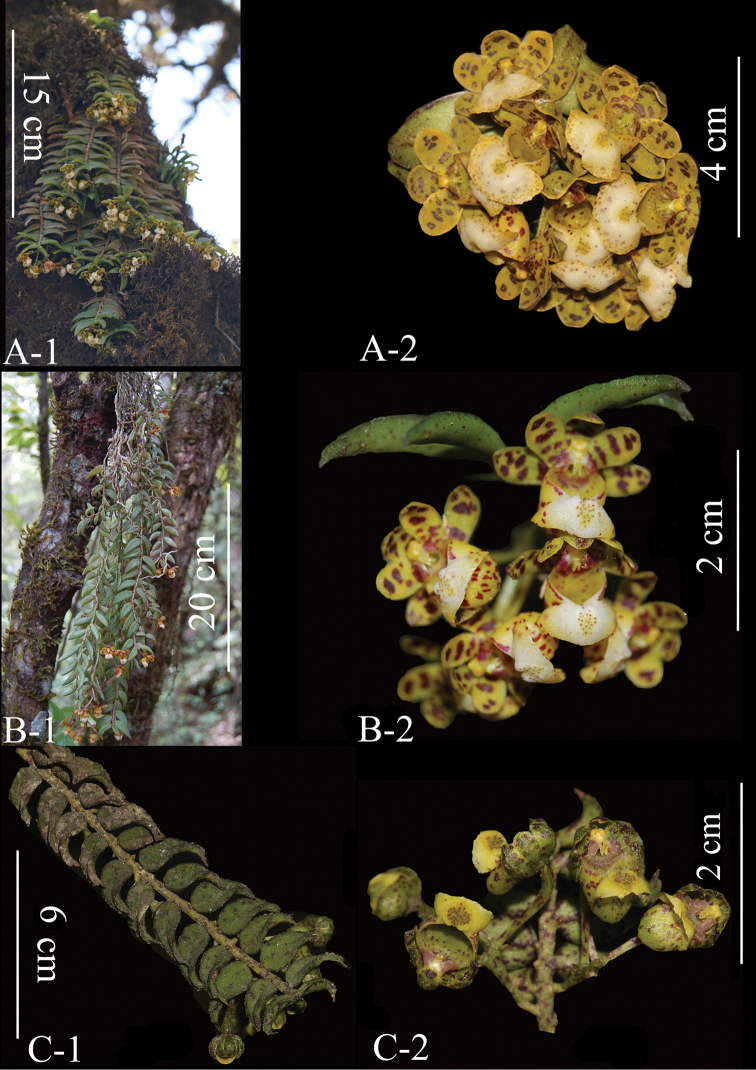
AGastrochilus
corymbosus (A-1 Plant A-2 Inflorescence and flowers) BG.
distichus (B-1 Plant B-2 Inflorescence and flowers) CG.
prionophyllus (C-1 Plant C-2 Inflorescence and flowers) (Photographed by Q. Liu).